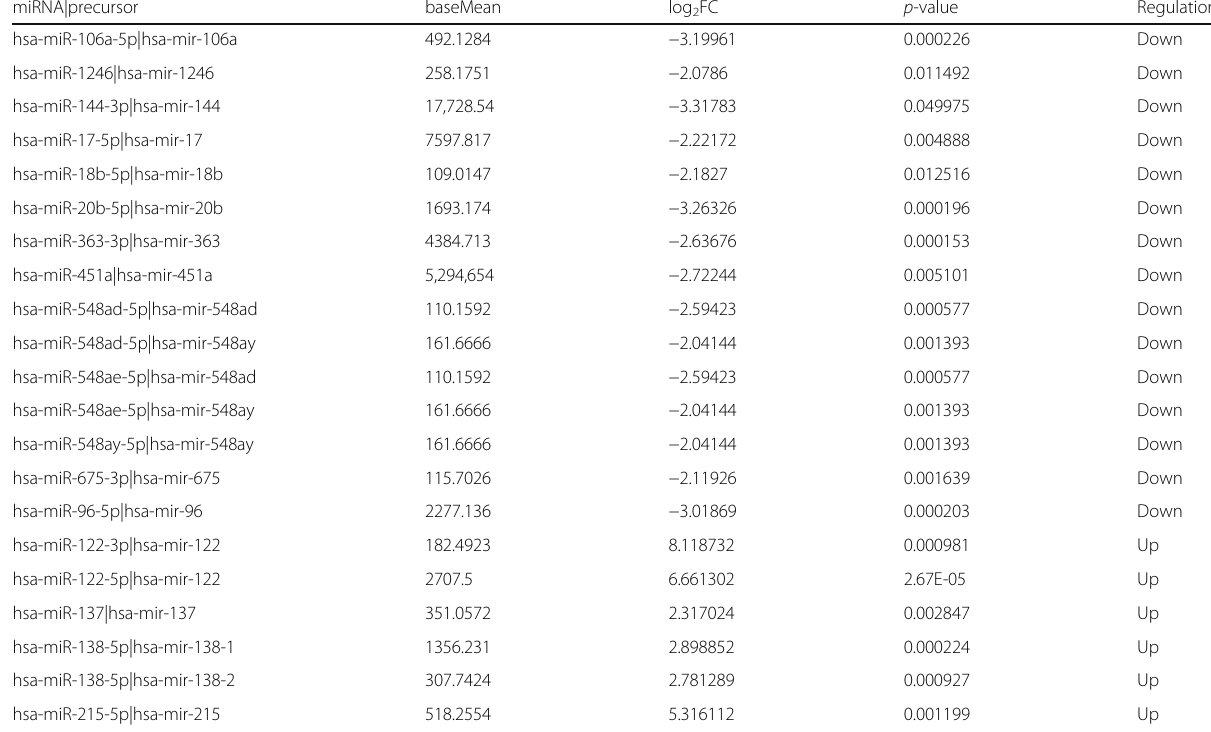
were the top three DEmiRNAs that covered most DEmRNAs. Functional annotation of DEmiRNA targets Base on GO enrichment analysis, RNA processing ( p = 5.80E-04), response to activity ( p = 9.04E-04), nucleus ( p = 3.56E-04) and alpha-tubulin binding ( p = 5.80E-04) were significantly enriched GO terms in OA (Fig. 5a-c). According to the KEGG pathway enrichment analysis, the DEmiRNA-target DEmRNAs were significantly down DEmRNAs Differentially expressed mRNAs, FC Fold change Table 3 DEmiRNAs between patients with OA and normal controls miRNA|precursor baseMean log 2 FC p -value